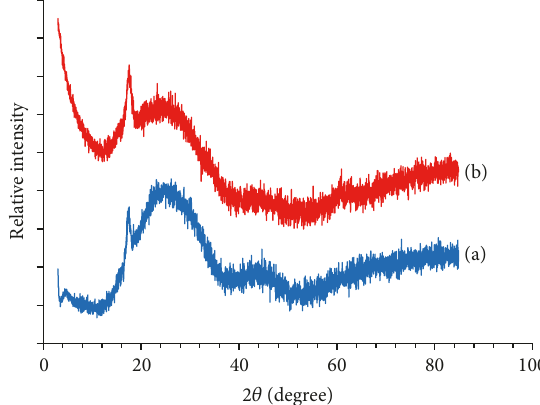
Figure 8: XRD powder pattern of CoNPs (12: 1) (a) and CoNPs (16: 1)